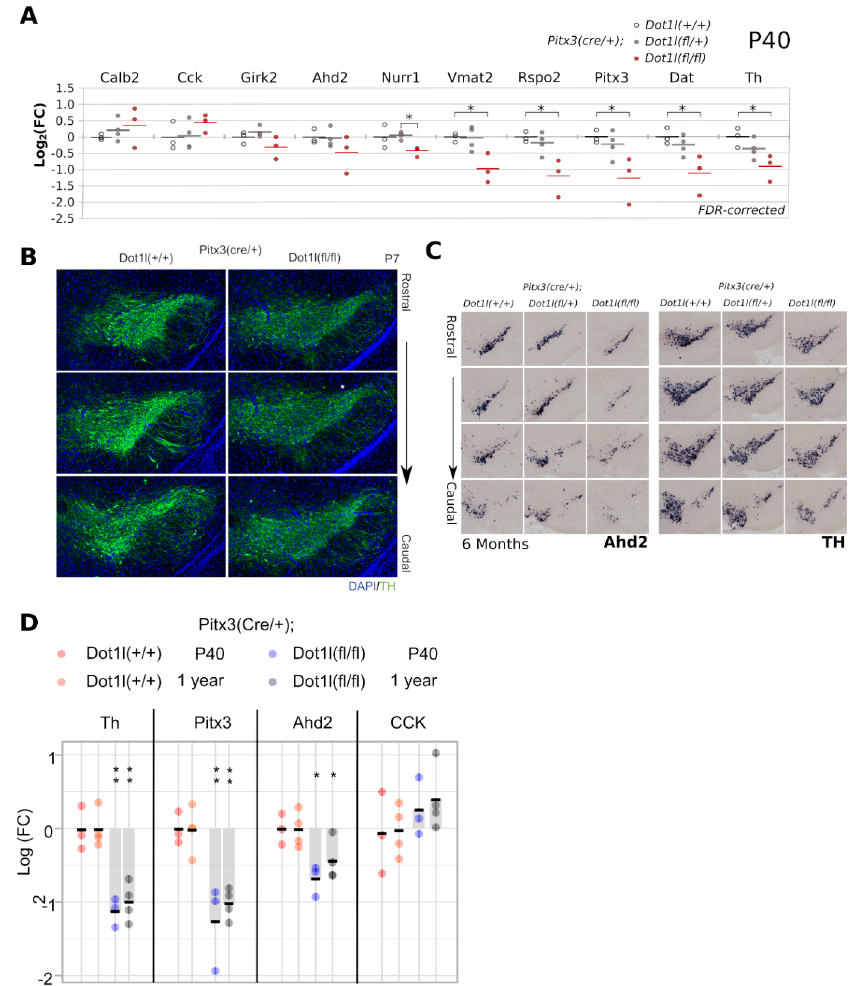
Figure 3. Neuronal defect in Pitx3(Cre / +) ; Dot1l(fl / fl) mice. ( A ) Quantitative PCR of dopaminergic and midbrain (subset) markers on dissected P40 midbrains. White dots represent Dot1l(+ / +) (n = 3), gray dots represent Dot1l(fl / +) (n = 4), red dots represent Dot1l(fl / fl) (n = 3), all in a Pitx3(Cre / +) background. Levels were normalized against Tbp transcript levels. ( B ) Immunohistochemistry for Th in P7 coronal sections of rostral Pitx3(Cre / +) ; Dot1l(+ / +) and Dot1l(fl / fl) mice. (10 × lens) ( C ) In situ hybridization of Ahd2 and Th transcripts in coronal slices of 6-month-old mice from more rostral to caudal, comparing Dot1l(+ / +) , Dot1l(fl / +) and Dot1l(fl / fl) , showing especially in the latter clear reductions. (10 × lens). ( D ) Quantitative PCR of dopaminergic and midbrain markers comparing p40 and one year old midbrains assessing mRNA levels of Th , Pitx3 , the rostro/ventral marker Ahd2 , and the dorso/caudal marker CCK similar as what observed in ( A ) and unchanged between p40 and 1-year-old Dot1l cKO mice. The red and orange dots represent Pitx3(Cre / +) ; Dot1l(+ / +) in P40 and 1-year-old mice, respectively. The blue and gray dots represent Pitx3(Cre / +) ; Dot1l(fl / fl) mice. Additional statistics: a one-tailed Student’s t -test was used with * FDR-corrected p <